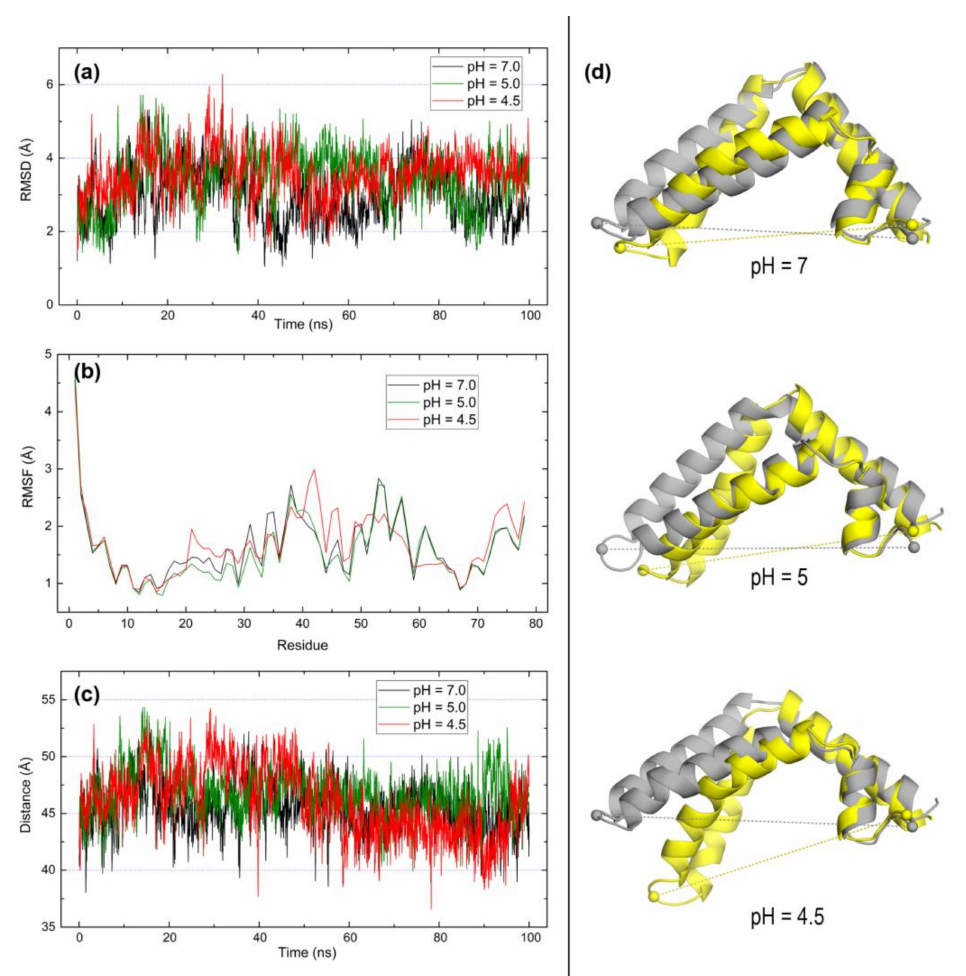
Figure 7. Results of 100-ns MD simulations on the open form of saposin B (chain A in 1N69) at pH 7, 5, and 4.5. ( a ) RMSD of backbone atoms. ( b ) RMSF of all residues. ( c ) Distance between alpha carbons of P41 and D78 residues. ( d ) Structural superposition of initial (yellow) and final (grey) structures in the simulations computed with TM-Align [42]. Dashed lines indicate distances between C α atoms of P41 and D78 represented as